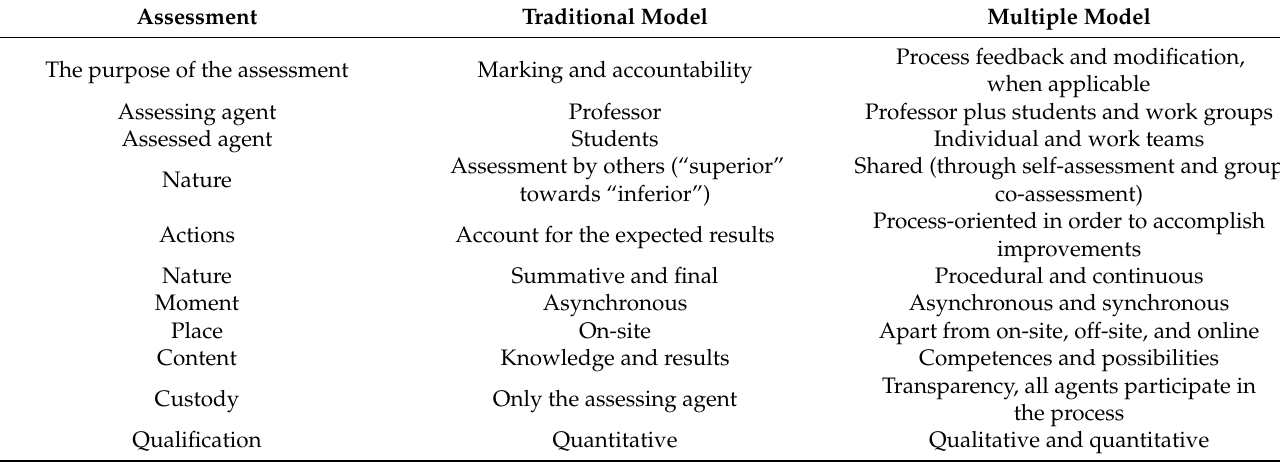
Table 1. Polarized assessment models: traditional versus